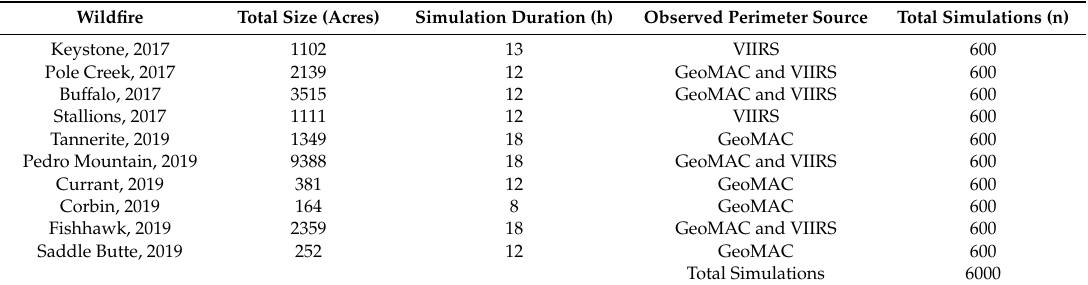
Table 2. Simulation parameters for the ten wildfires analyzed within this